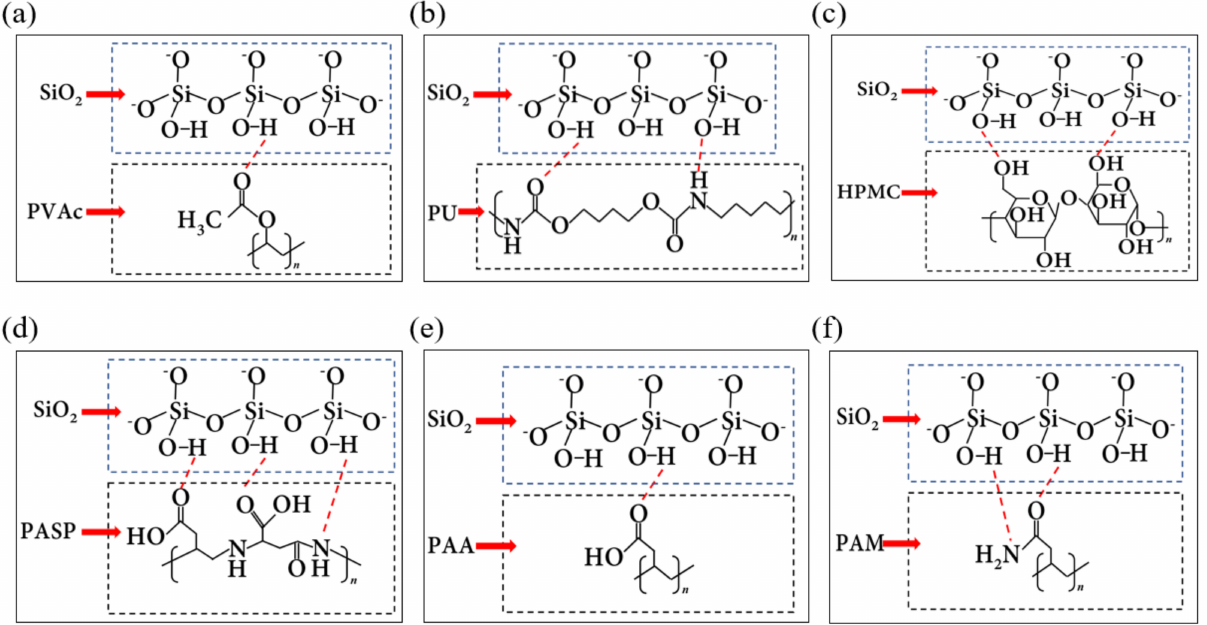
Figure 4. Hydrogen bonds formed by polymers (dotted lines in red in the image is the hydrogen bond). ( a ) PVAc, ( b ) PU, ( c ) HPMC, ( d ) PASP, ( e ) PAA, ( f )